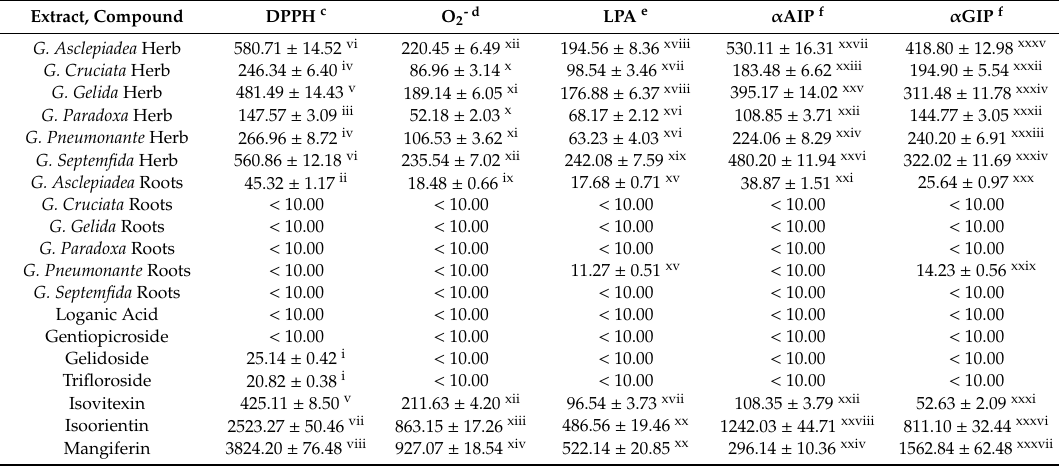
Table 3. Parameters of antioxidant activity and α -amylase / α -glycosidase inhibitory potential of gentian extracts and pure compounds a,b . Extract, Compound DPPH c O 2-d LPA e α AIP f α GIP f G. Asclepiadea